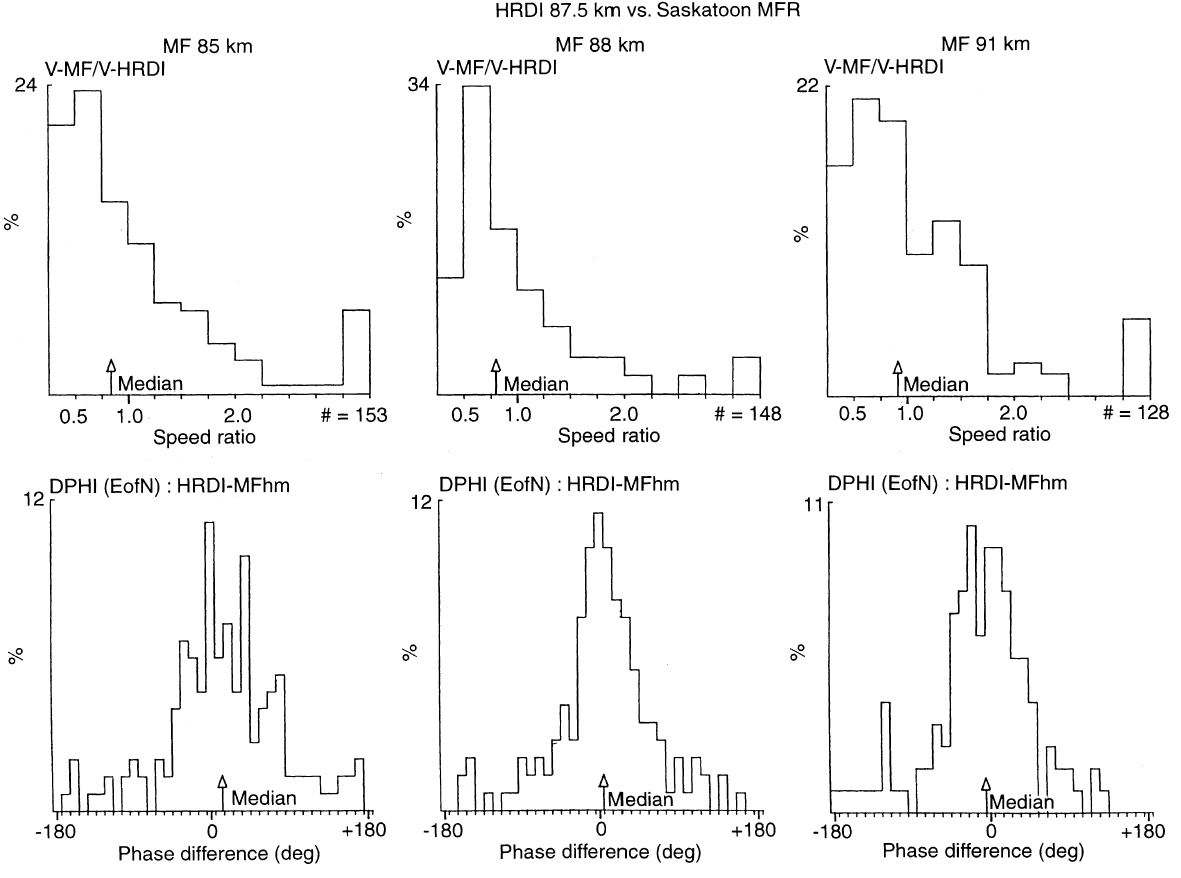
Fig. 5. Speed-ratio and direction-di(cid:128)erence histograms comparing single HRDI height data (87.5 km) with those from several adjacent MFR heights (85, 88, 91